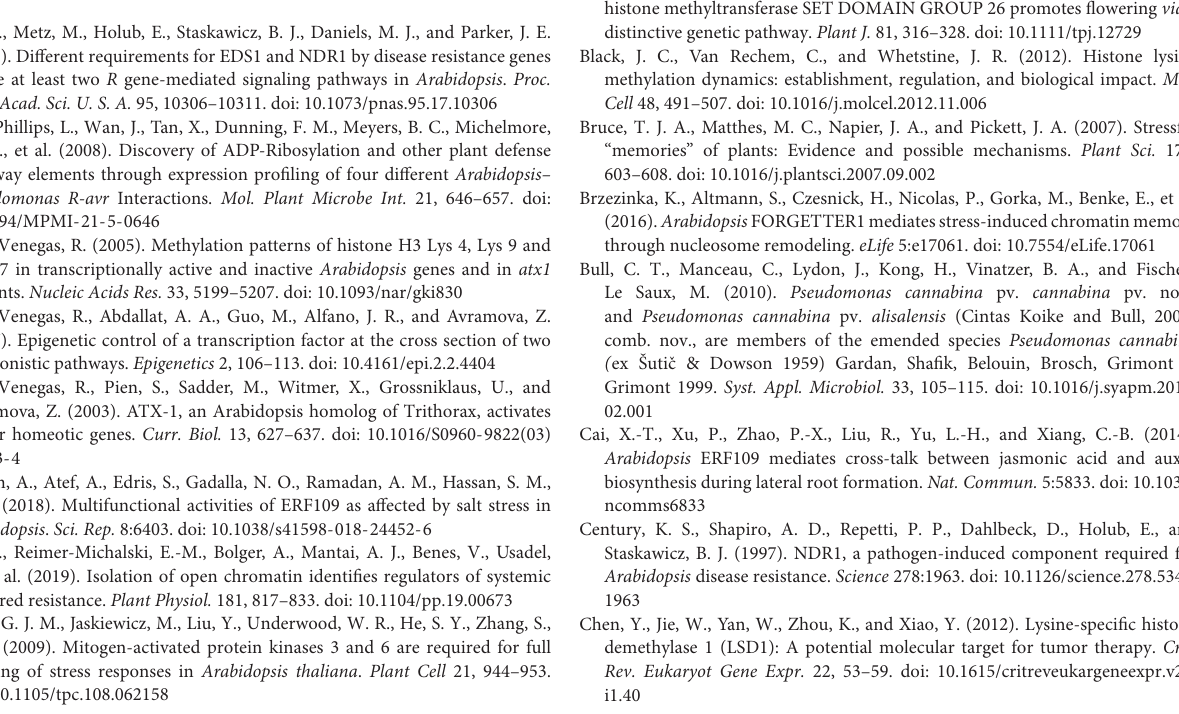
‘DNA-binding transcription factor activity’ (blue dots), and ‘response to chitin and to bacterium’ (green dots) ( Supplementary Figure 5E ) (B) Proteins involved in SA signaling pathways (PR1, NPR1, and ALD1), the PTI pathway (WRKY70, WRKY25, RFK1, YLS9, and AT1G51890), and a few putative targets of LDLS (WRKY22, WRKY40, ERF1, and RRTF1) were subjected to STRING analysis. Supplementary Figure 7 | Levels of modified histone H3 protein in WT and ldl1 ldl2 . (A - C) Nuclear proteins extracted from three independent biological replications (1 o , 2 o , and 3 o ) were subjected to SDS-PAGE, and immunoblot analysis was performed using α -H3K4me1 (A) , α -H3K4me2 (B) , and α -H3K4me3 (C) antibodies. Numbers indicate independent experimental trials. w, WT plants; m, ldl1 ldl2 . The normalized and processed data were plotted in Figure 5A . Supplementary Figure 8 | Monomethylation of histone H3K4 is associated with the transcription of genes encoding transcription factors in Arabidopsis. The plots represent the second of two independent biological replications of ChIP-PCR to examine the enrichment of modified histone H3 proteins in the identified Supplementary Figure 9 | A proposed model about the role of LDL1 and LDL2 in the transcription of defense-related genes in Arabidopsis . A previous study reveals that Arabidopsis requires ATX1/SDG25 for monomethylation of histone H3K4, and its KO mutants were susceptible to Pst DC3000 infection. On another side, both LDL1 and LDL2 are responsible for suppressing the immoderate expression of defense-related genes in the absence of pathogen infection. Thus, it is likely that the prevention of detaching methyl group of H3K4 in nucleosome associated with defense-related genes is enough to prime plants against subsequent pathogen infection. Supplementary Table 1 | Bacterial strains used in this study. Supplementary Table 2 | Oligonucleotide sequences used in this